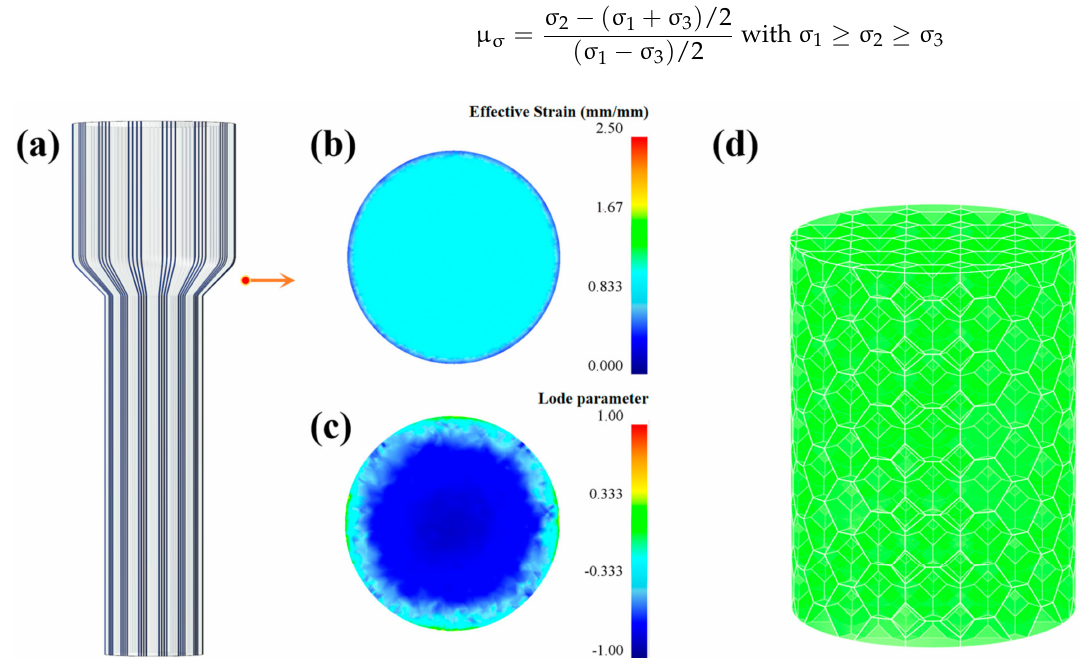
Figure 17. Schematic diagram summarizing the mechanism of microstructure evolution during CE: ( a ) schematic diagram of metal flow direction subject to CE; ( b ) effective strain in the deformation zone; ( c ) load parameter in the deformation zone, and ( d ) schematic diagram of the microstructure after CE.